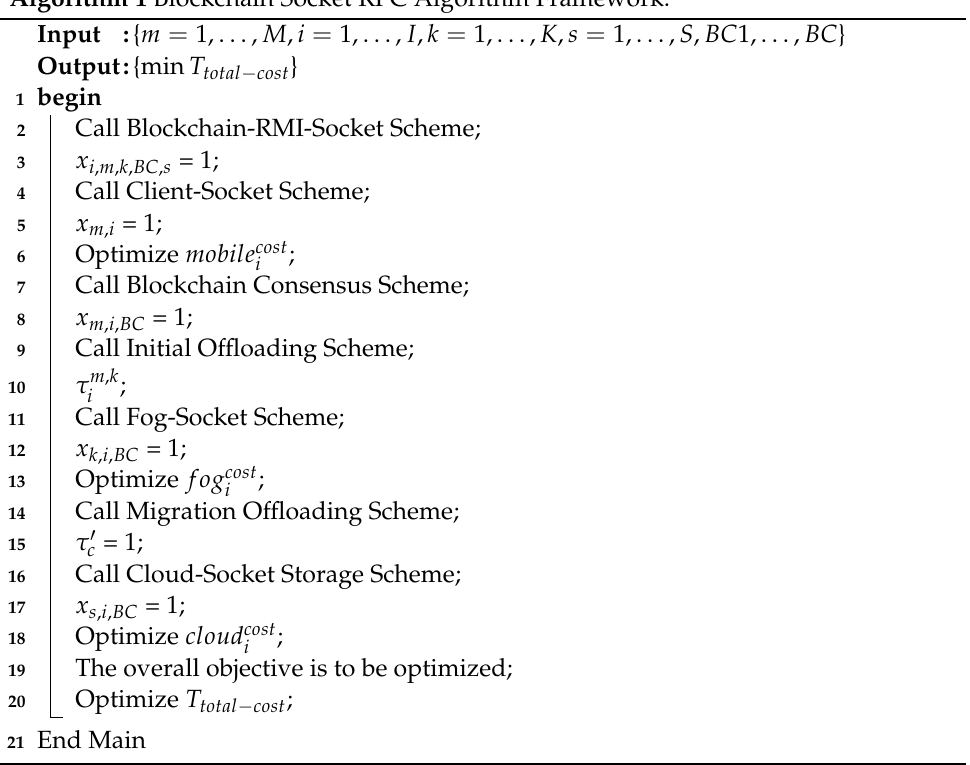
Algorithm 1 Blockchain Socket RPC Algorithm